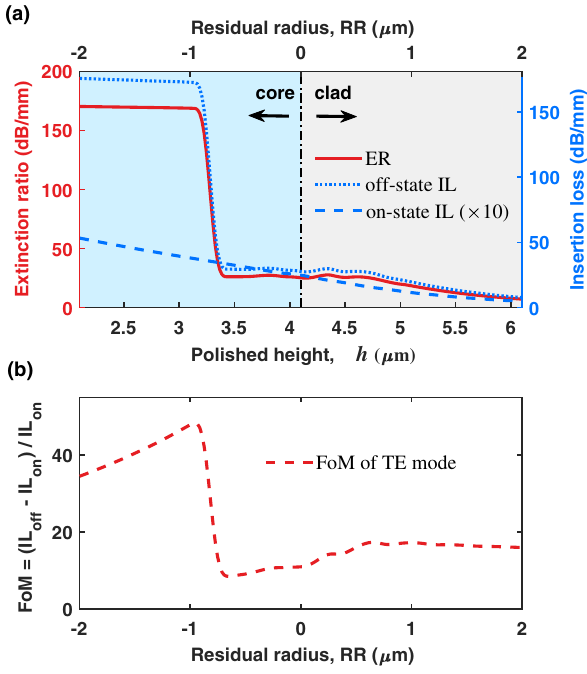
Figure 5: (a) The extinction ratio and insertion loss (i.e. the on-state IL) of the TE modulator as a function of both polished height and residual radius. (b) FoM of the TE modulator versus the residual